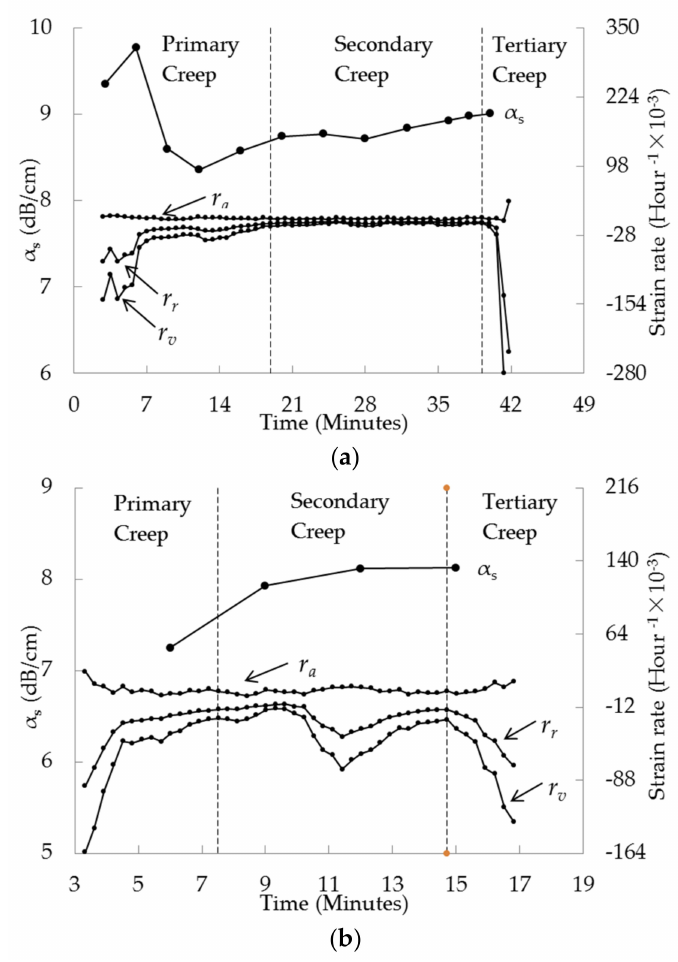
Figure 15. Graph of spatial attenuation parameters and strain rates versus time for Type 3 creep. Results are shown for tests at: ( a ) 11.02 MPa; ( b ) 15.99 MPa. r a , r v , r r , and α s denote axial strain rate, volumetric strain rate, radial strain rate, and spatial attenuation parameter, respectively. The dashlines denote the transition points of creep